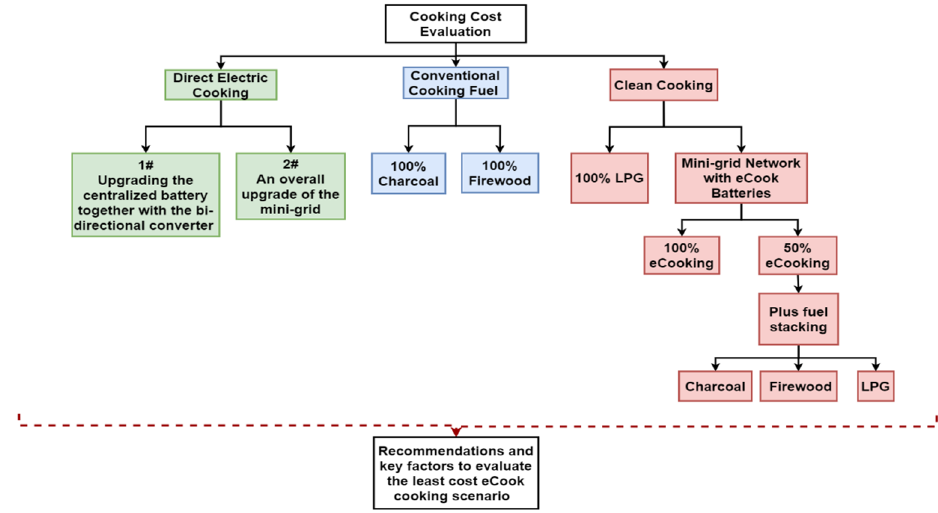
Figure 1. Contextualized cooking scenarios to evaluate the monthly cooking cost. From Figure 1 “Direct Electric Cooking” is split into two eCook scenarios: